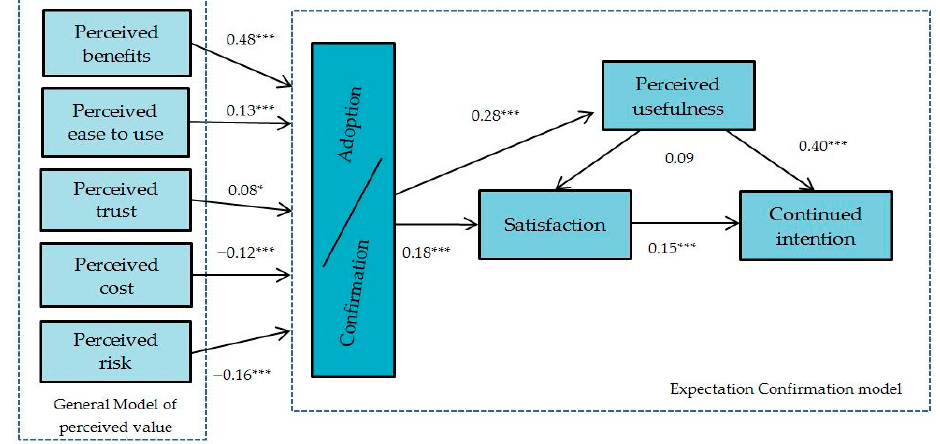
Figure 3. Results of the proposed